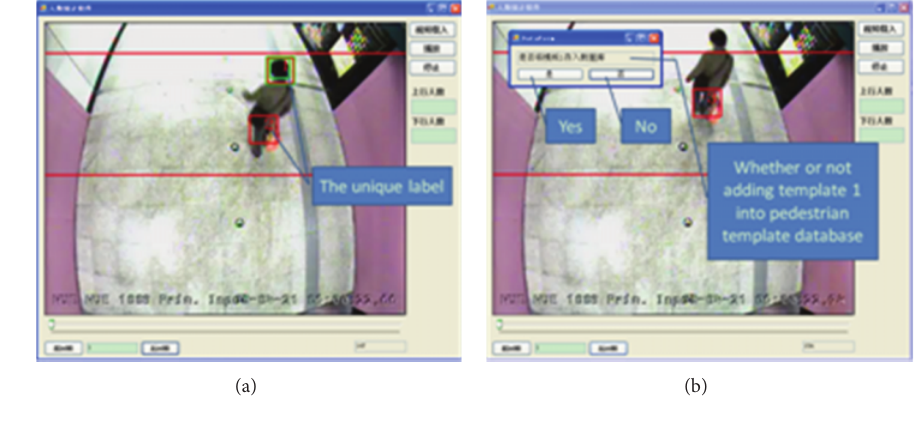
Figure 9: Data collection software. Table 1: Template update.